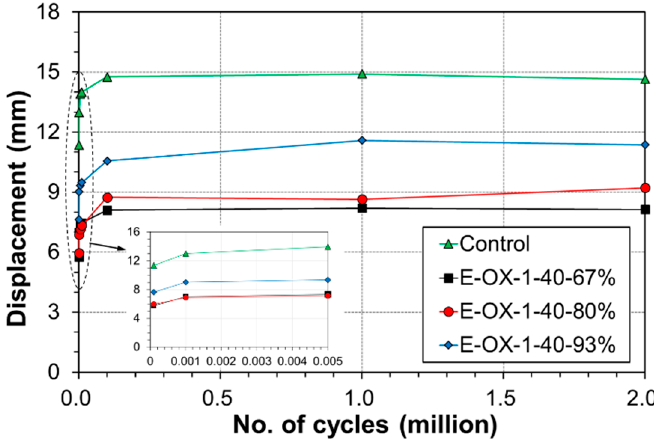
Figure 11. Variation of mid-span deflection during fatigue loading at upper load limit.